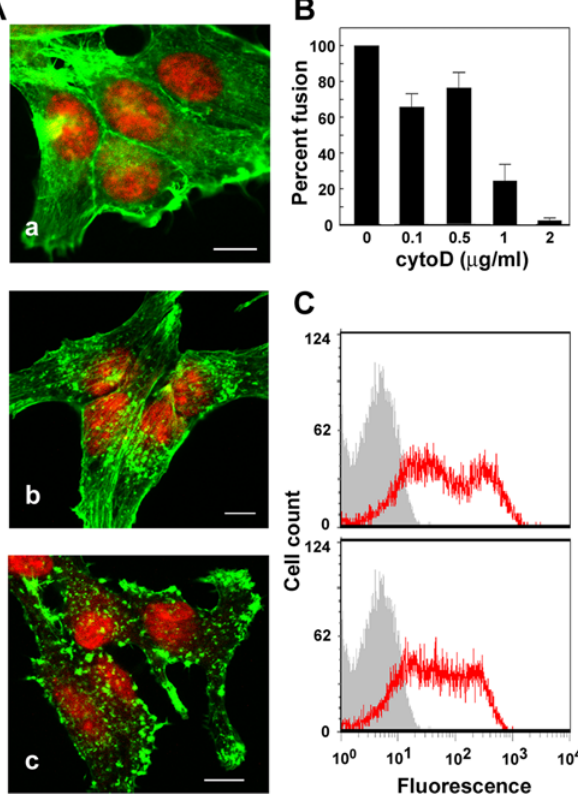
Figure 9. Effects of cytoD on QM5 cell adhesion and p14- induced syncytiogenesis. (A) Fluorescent images of QM5 fibroblasts treated with 0 (a), 0.5 (b) or 1 m g/ml (c) of cytoD for 30 minutes prior to fixation and staining with fluorescently conjugated phalloidin (green) and propidium iodide (red). Scale bars=10 m m. (B) Cell–cell fusion in QM5 cells treated with the indicated concentrations of cytoD was quantified at 7 h post-transfection by syncytial indexing. Data is presented as the extent of fusion relative to cells untreated with cytoD, set at 100%. Values represent the mean 6 S.E. (n=3). (C) QM5 fibroblasts transfected with p14 and left untreated (top panel) or treated with 0.1 m g/ml of cytoD for 1 h (bottom panel) were surface immunostained using an anti-p14 ectodomain-specific antiserum and Alexa Fluor 488- conjugated secondary antibody (red line tracing) and analyzed for cell- surface fluorescence (in arbitrary units) by flow cytometry relative to mock-transfected cells (grey histogram).